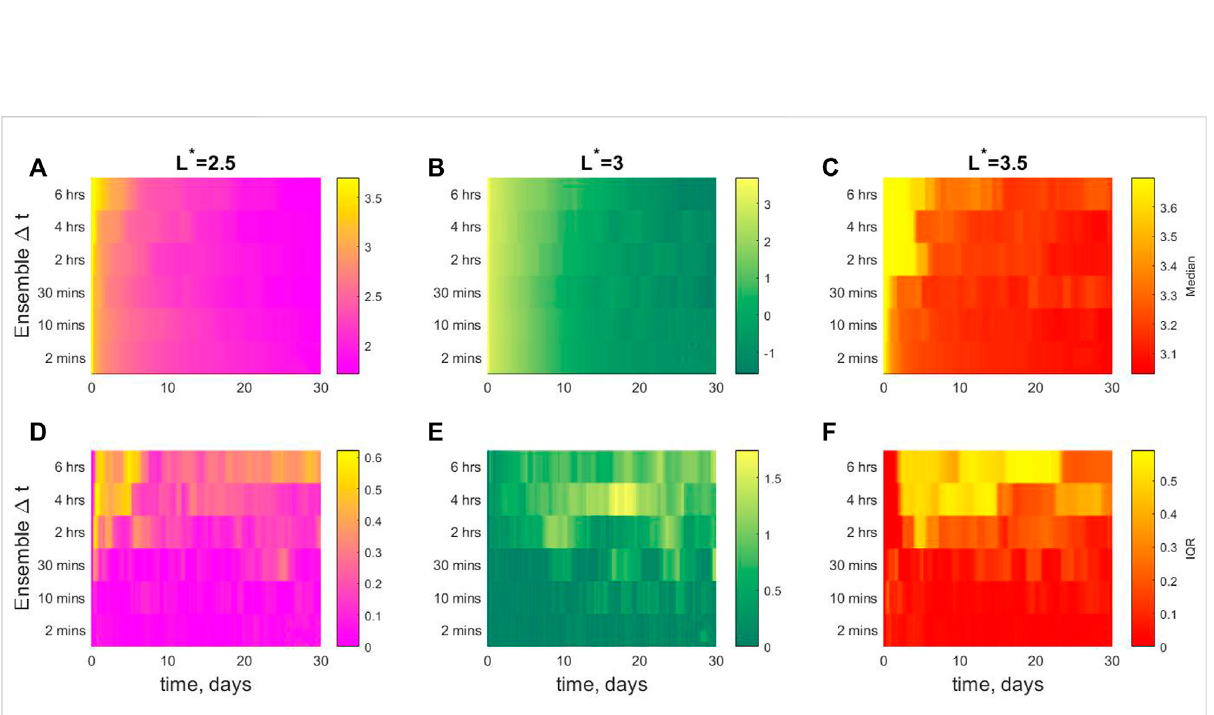
Summary fi gure for each L * set of experiments (A – C) median of log 10 ( f ( α LC )) and (D – F) IQR of log 10 ( f ( α LC